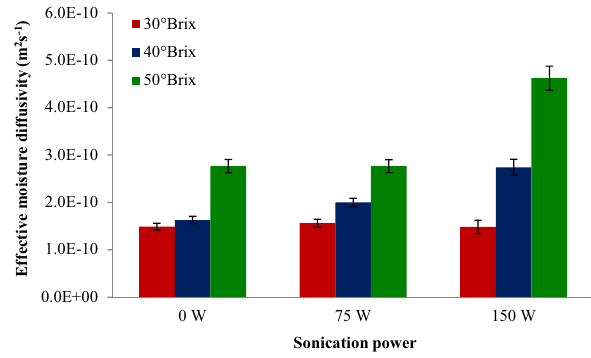
Figure 10. The interaction impacts of sonication power levels and osmotic solution concentrations on the effective moisture diffusivity (D eff ) values of apple slices during osmotic